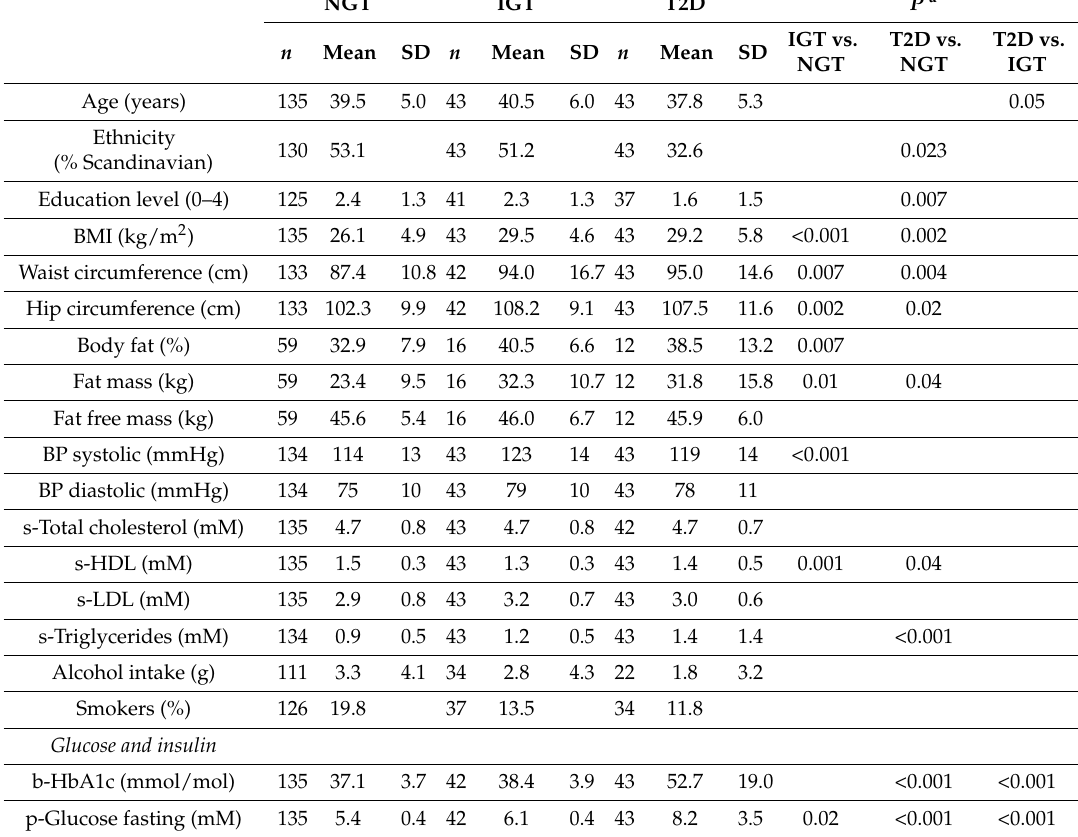
Table 1. Characteristics of women 6 years after a GDM pregnancy. Women were divided into glucose tolerance groups based on OGTT at 6-year visit; type 2 diabetes (T2D) was determined by OGTT at time of diagnosis or at 6-year visit.